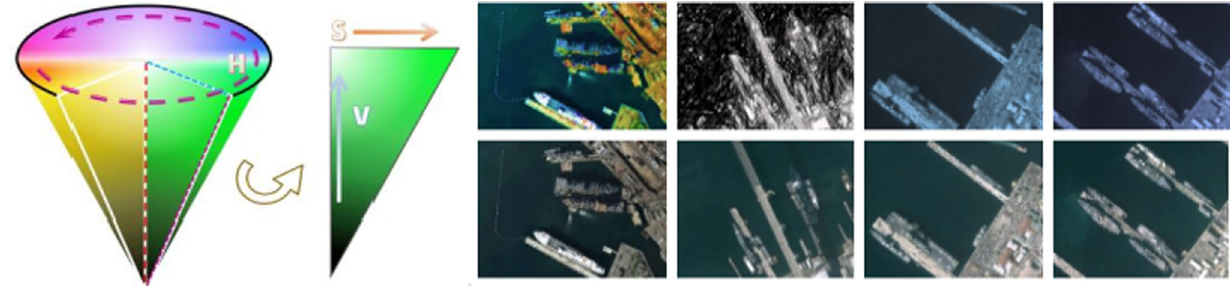
Fig. 3 HSV augmentation for color-oriented data